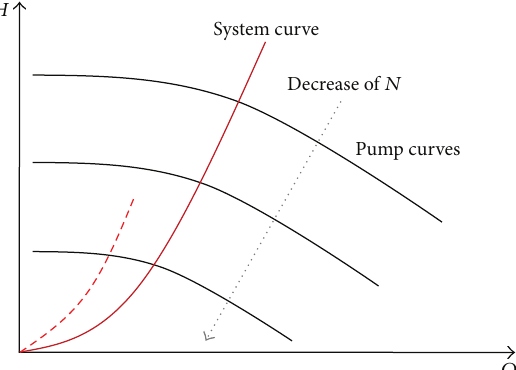
Figure 4: Change of the system resistance curve with the decrease of the flow